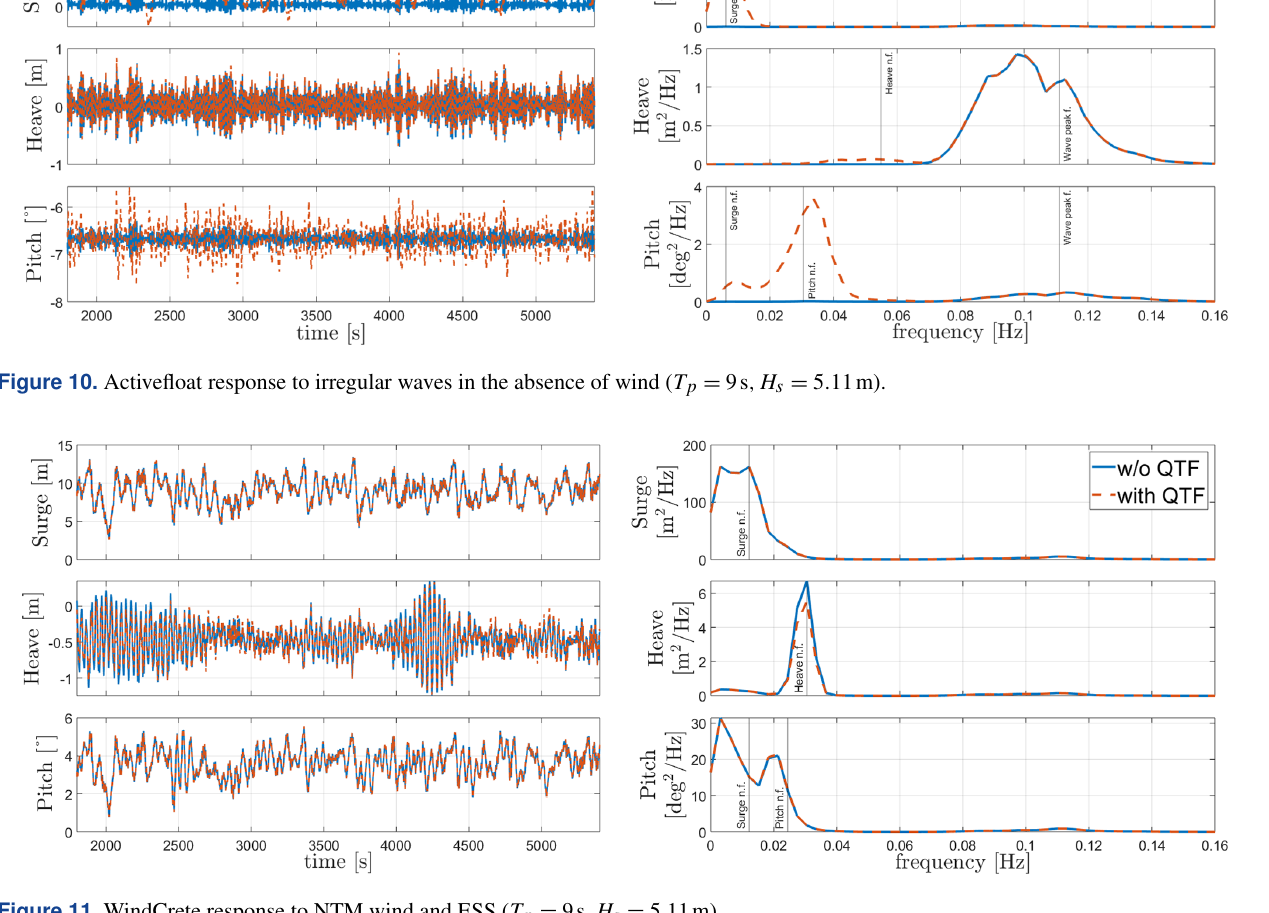
https://doi.org/10.5194/wes-6-867-2021 Wind Energ. Sci., 6, 867–883,